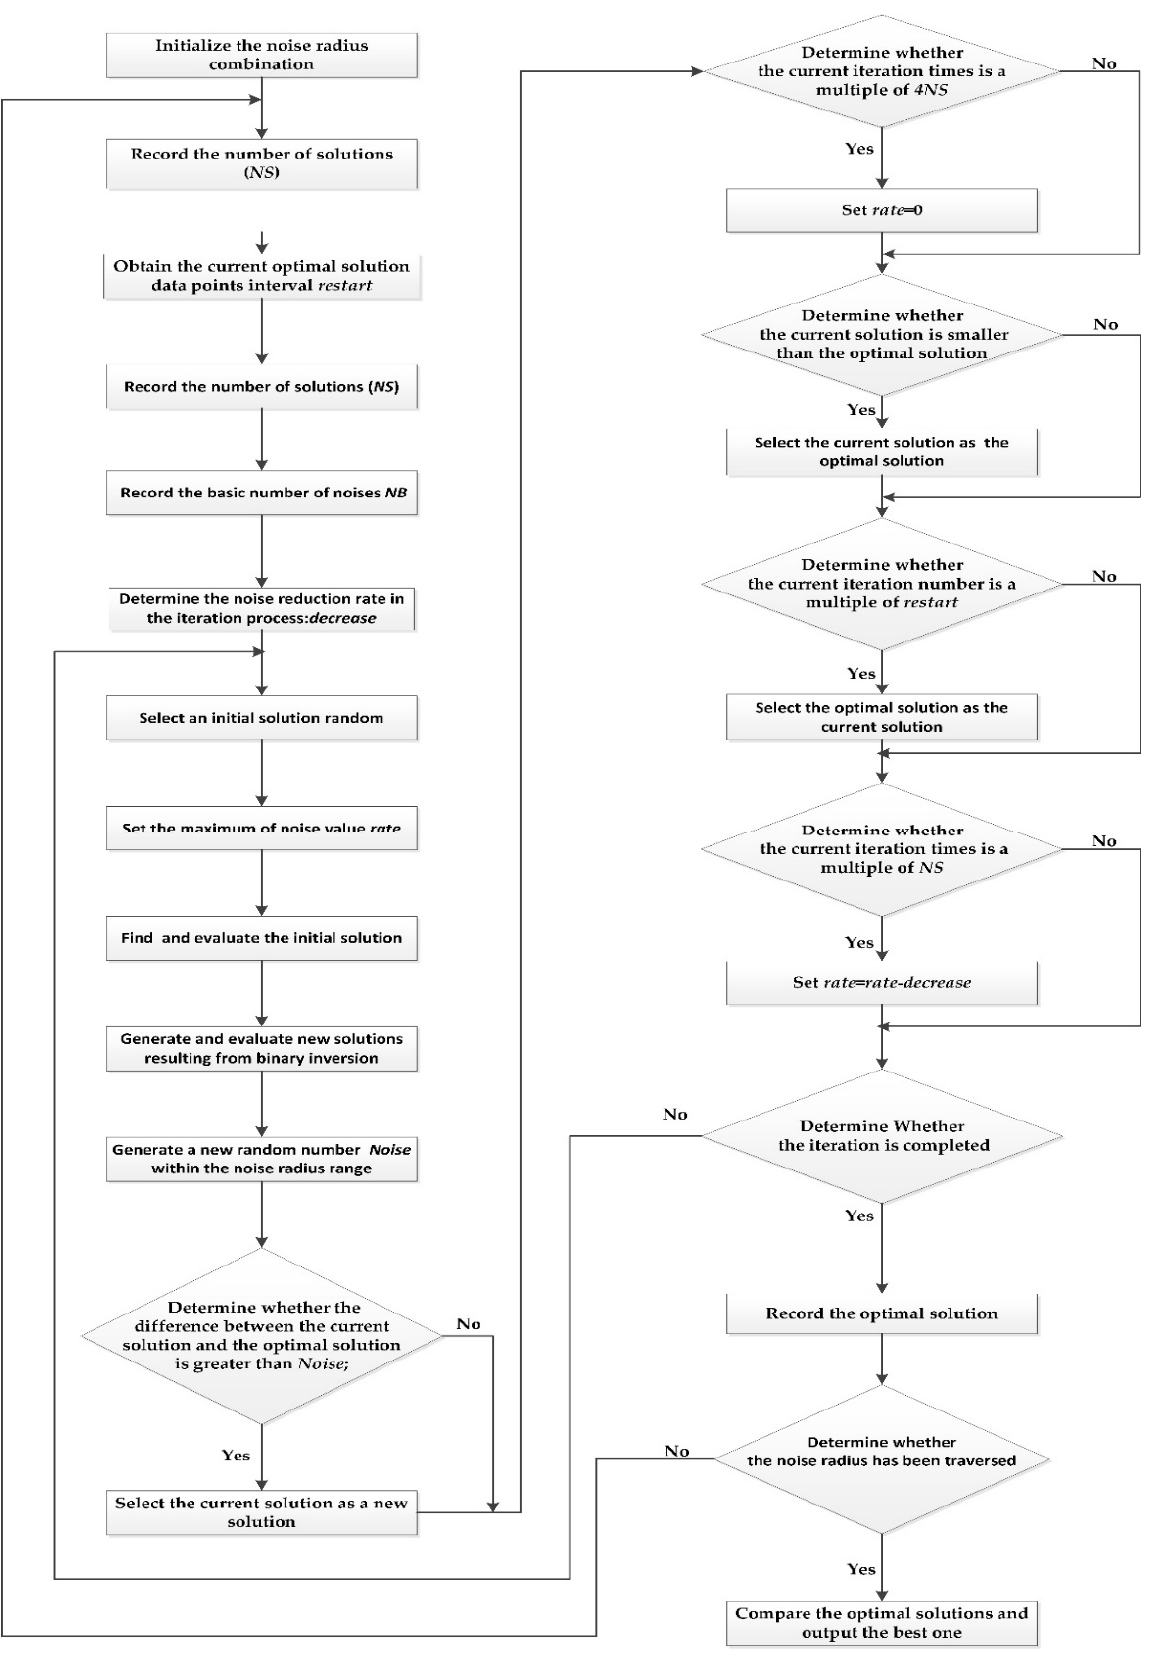
Figure 2. The flow of the noise-based K-means clustering algorithm.